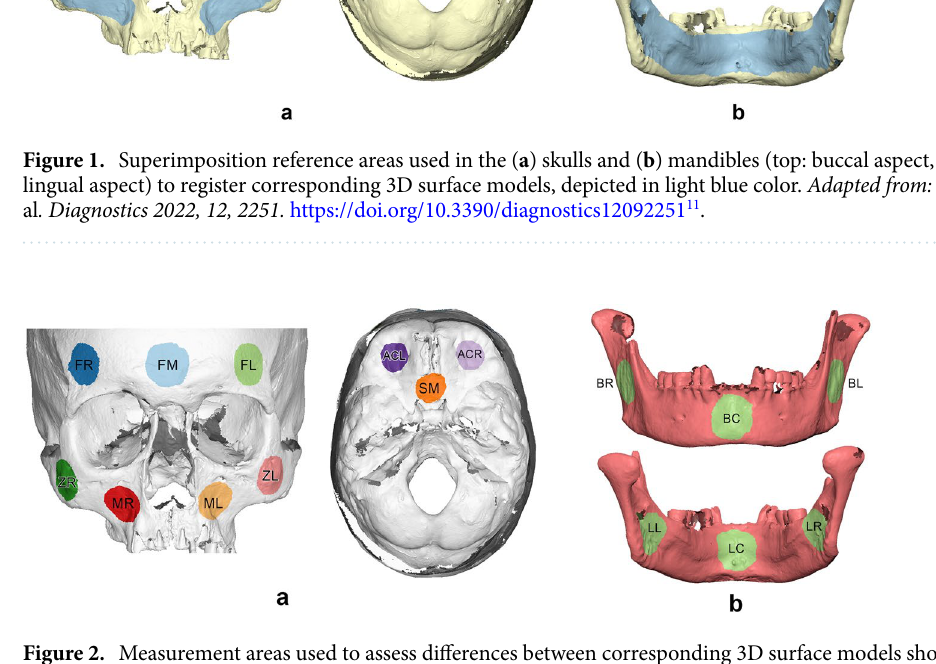
Figure 2. Measurement areas used to assess differences between corresponding 3D surface models shown as colored round surfaces. ( a ) Skull. Forehead left (FL), right (FR) and middle (FM), maxilla left (ML) and right (MR), zygomatic bone left (ZL) and right (ZR), anterior cranial base left (ACL) and right (ACR), sphenoid bone middle (SM). ( b ) Mandible. Upper image: Buccal left (BL), right (BR) and center (BC). Lower image: Lingual left (LL), right (LR) and center (LC). Adapted from: Probst et al . Diagnostics 2022, 12, 2251. https:// doi. org/ 10. 3390/ diagn ostic s1209 2251 11